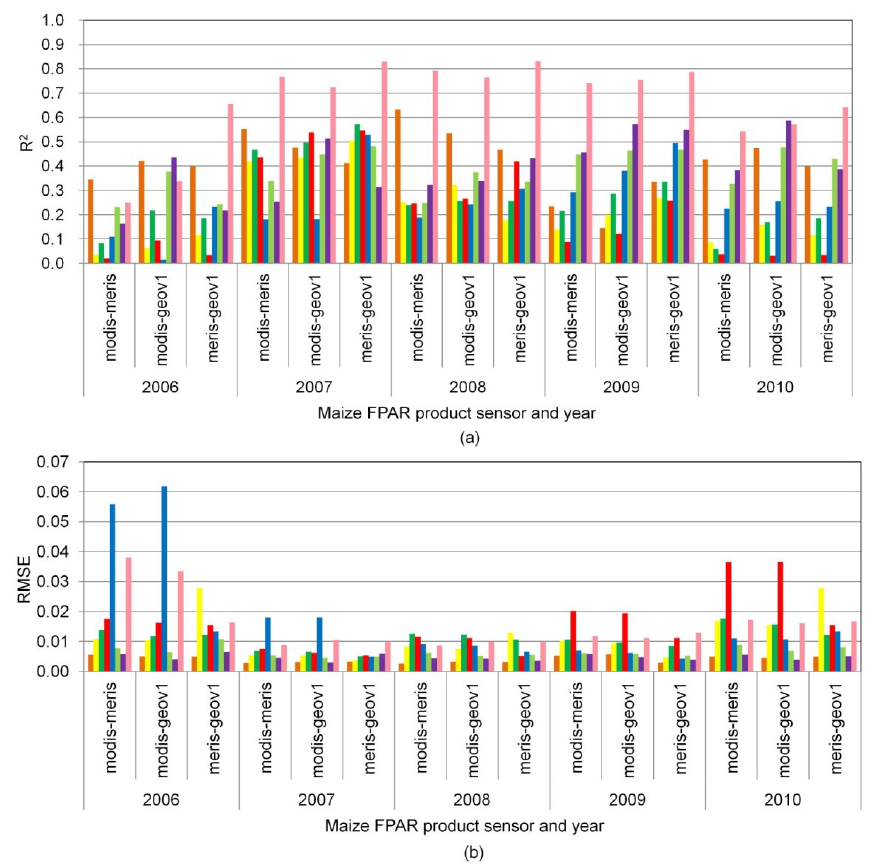
Figure 5. The regression R 2 and RMSE among three FPAR products for maize ( a ) Regression R 2 ; ( b ) RMSE and winter wheat ( c ) Regression R 2 ; ( d )